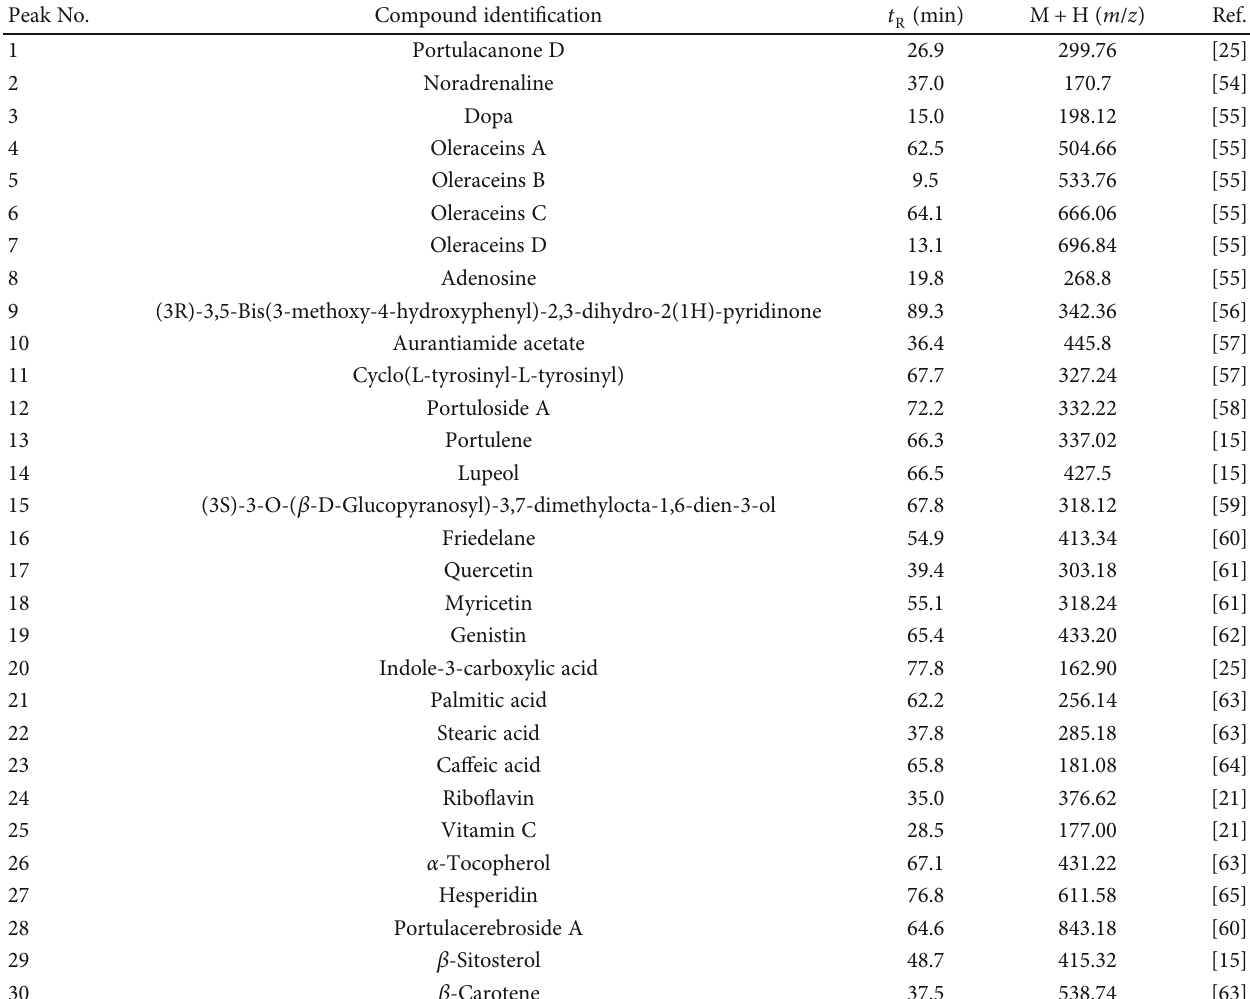
Table 3: Peak assignment of metabolites in the hydroethanol extract of PO using LC-MS in the positive mode. Peak No.